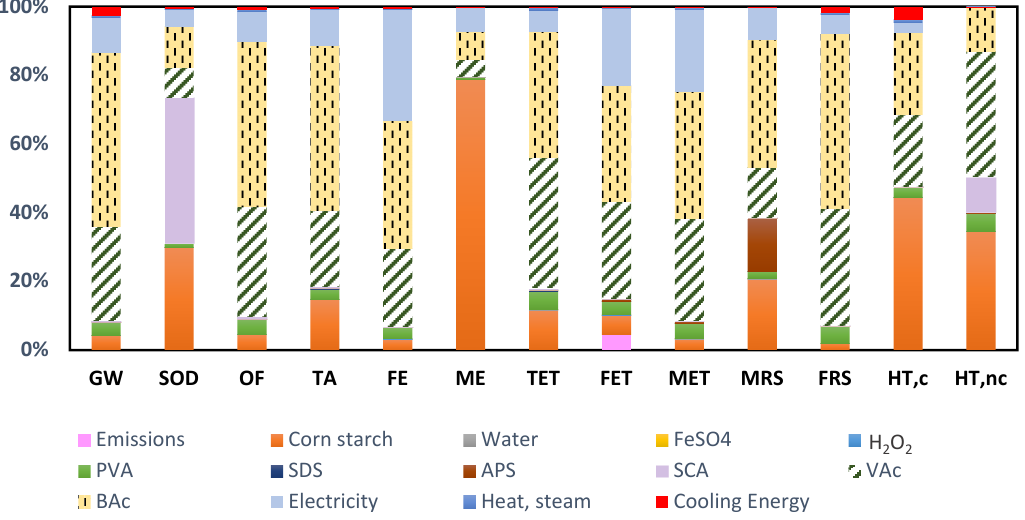
Figure 4. Environmental profile of the starch bioadhesive oxidized with FeSO 4 and H 2 O 2 (Alternative 3).